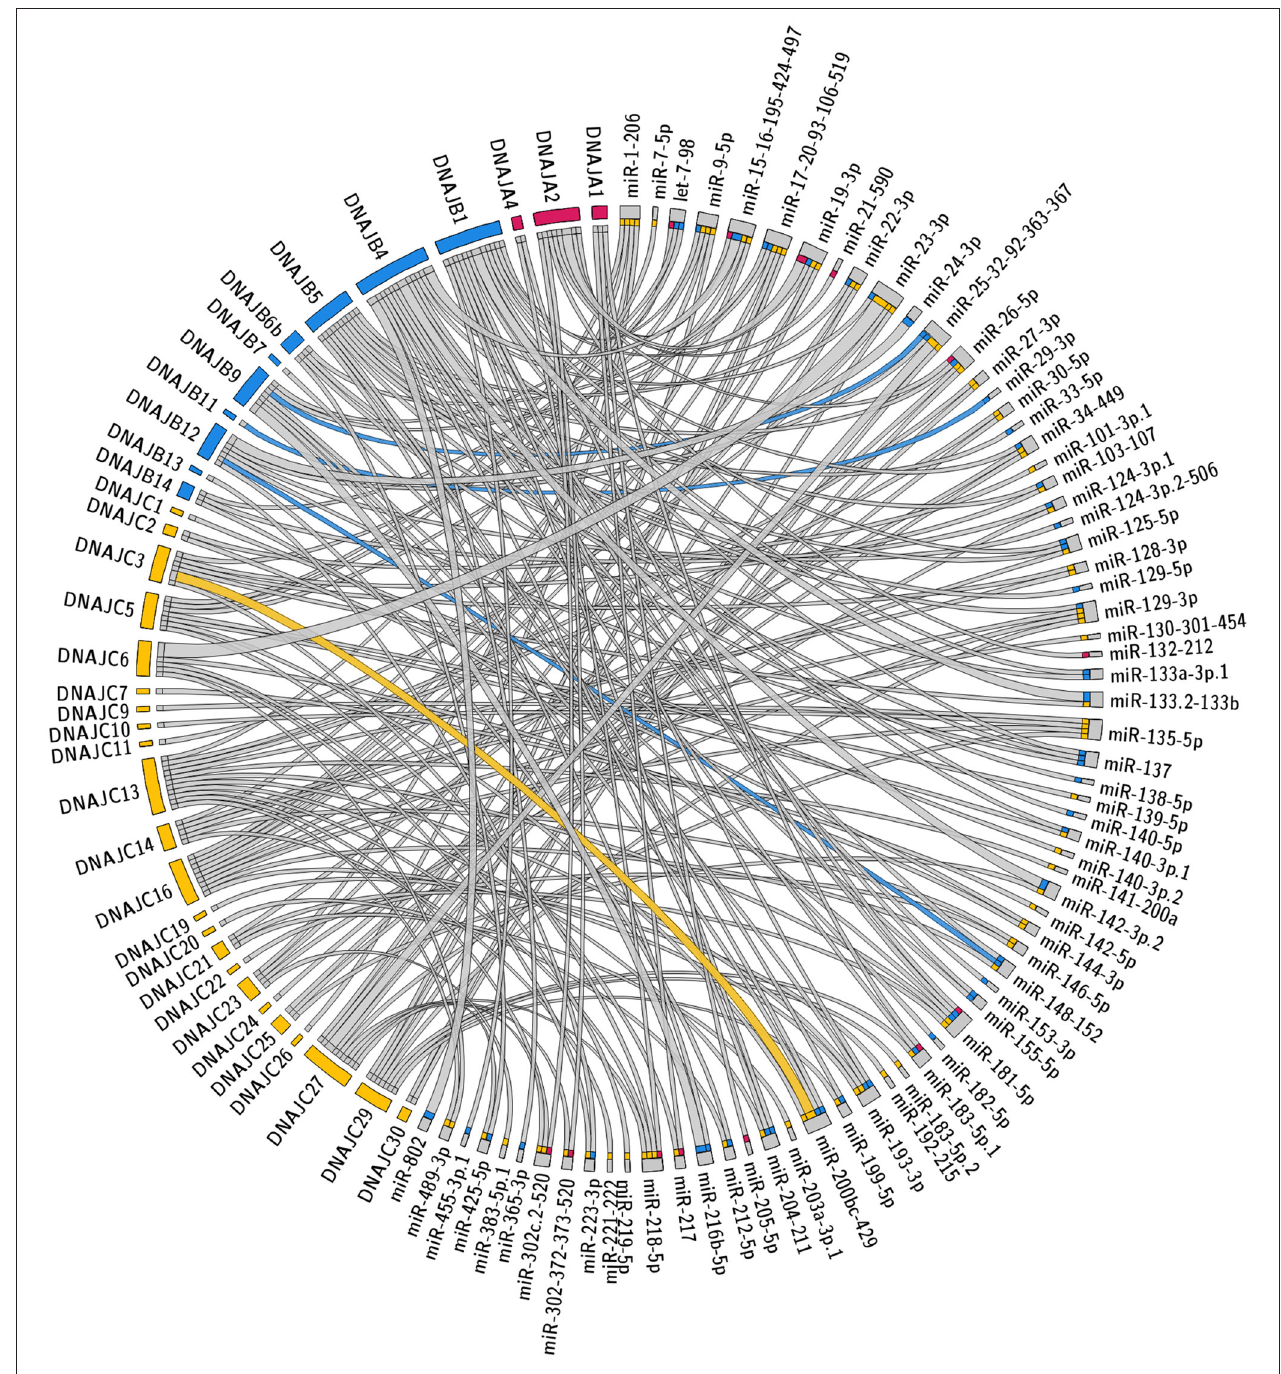
FIGURE 2 | Predicted miRNA targets for miRNAs broadly conserved in vertebrates. Interaction Circos plot (Krzywinski et al., 2009) for TargetScan depicting targeting of J-Proteins by miRNA families that are broadly conserved throughout vertebrates. For each J-Protein, miRNAs with a context score of < − 0.1 were extracted from TargerScan (Agarwal et al., 2015). Unconserved target sequences for miRNAs that were not conserved were excluded from the analysis. A colorized line indicates miRNA targeting that has been experimentally verified and the width of the bridging lines is proportional to the number of predicted target